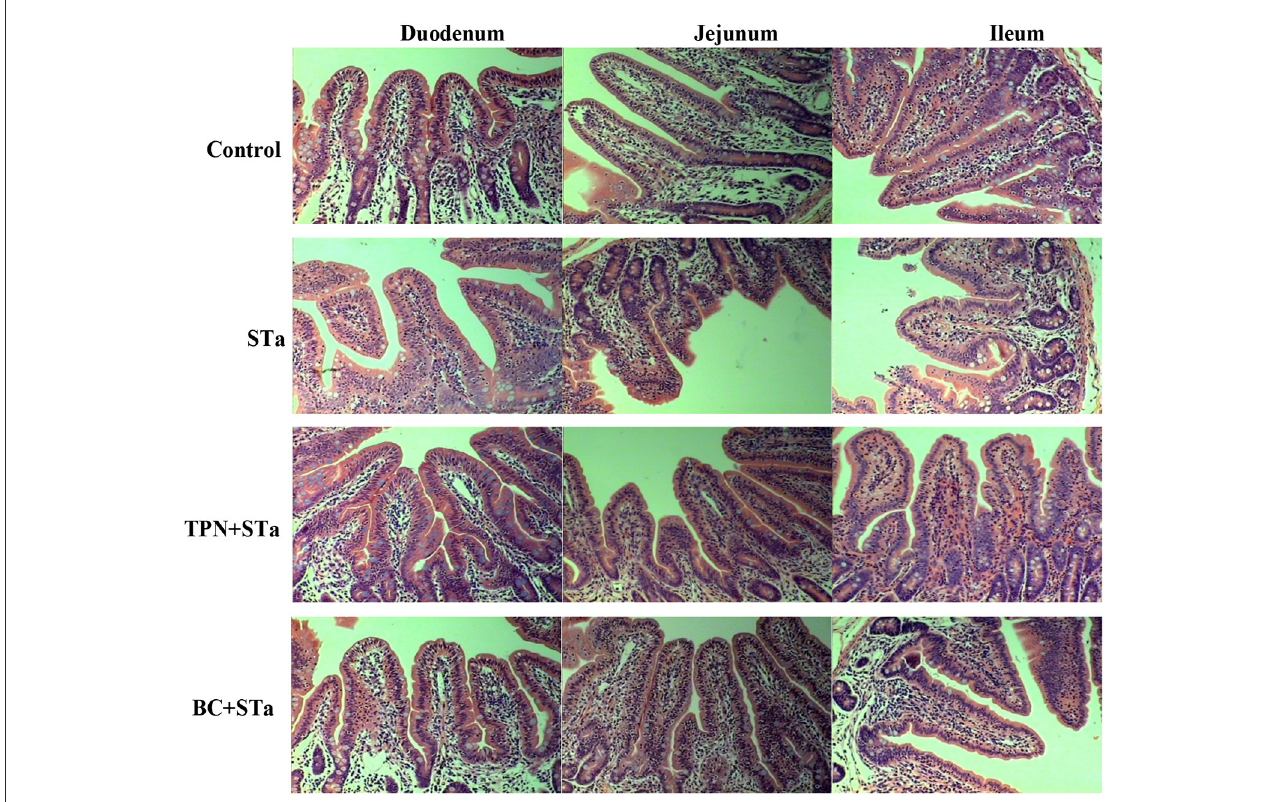
FIGURE1 Intestinal mucosal morphology observed by H&E staining under an optical microscope. Magnification x 200.